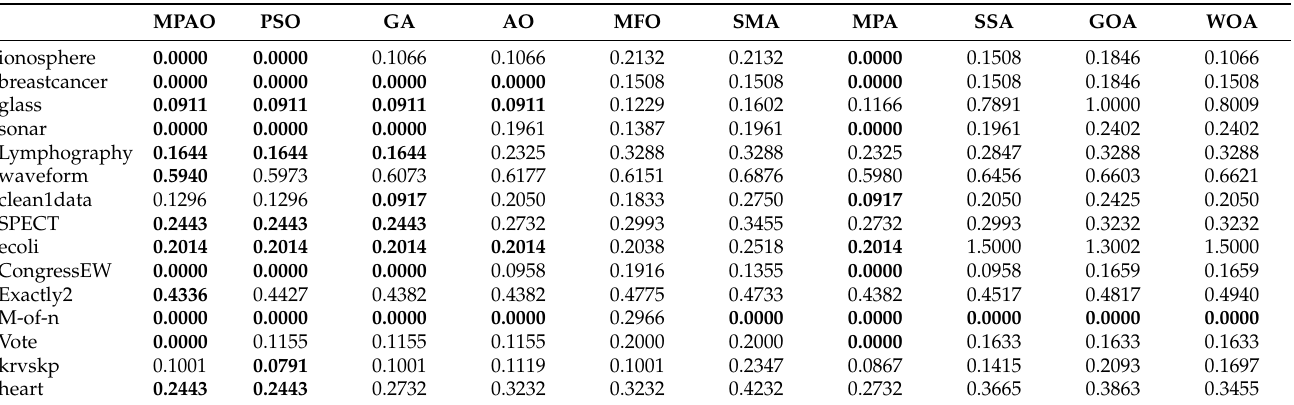
Table 8. Results of the minimum value of the fitness